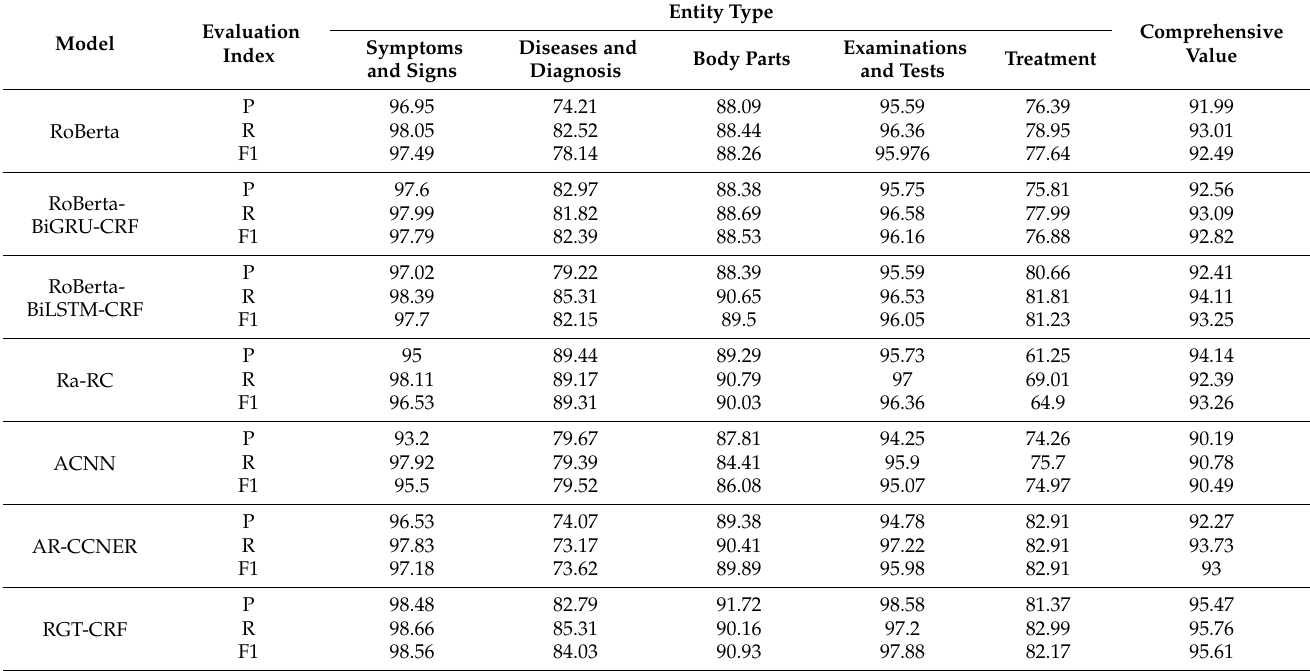
Table 3. Results of different models on